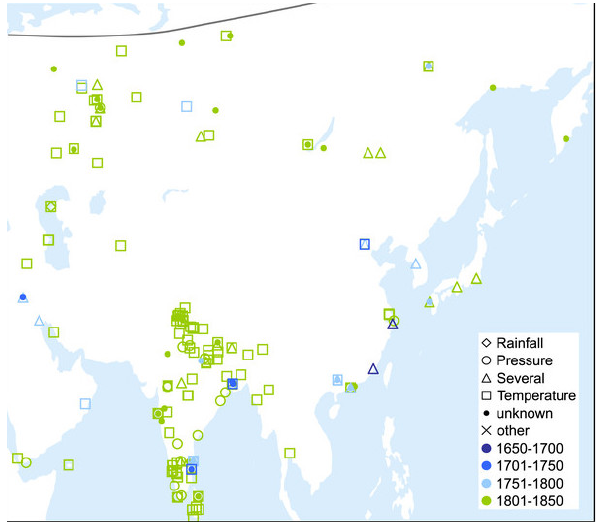
Figure 1. Series inventoried for Asia pre-1850 (Fig. 5 from Brön- nimann et al.,